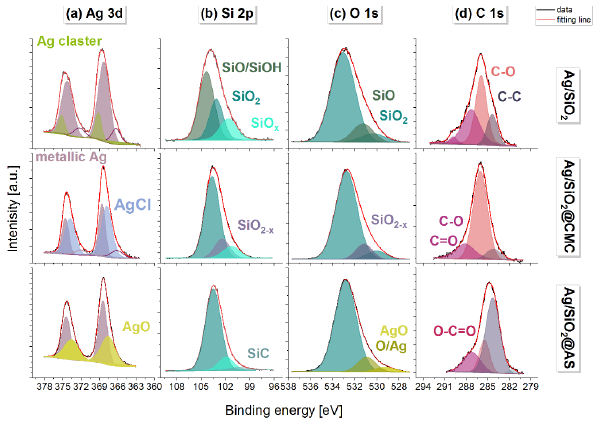
Figure 6. The XPS spectra of ( a ) Ag 3d, ( b ) Si 2p, ( c ) O 1s, and ( d ) the C 1s core levels with the fitting result. The individual colors on the specific lines' core levels refer to the individual chemical surroundings linked to the silver, silica, oxygen, and carbon.